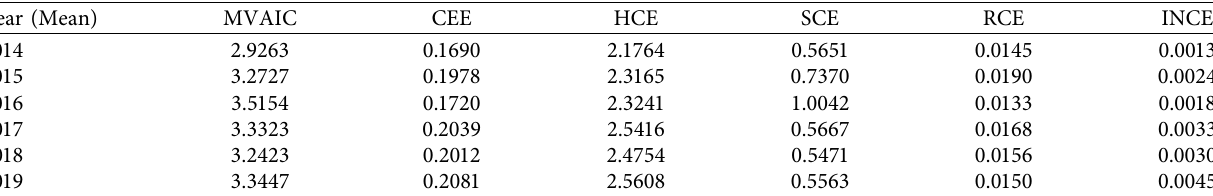
Table 2: Yearwise means for IC and its components.